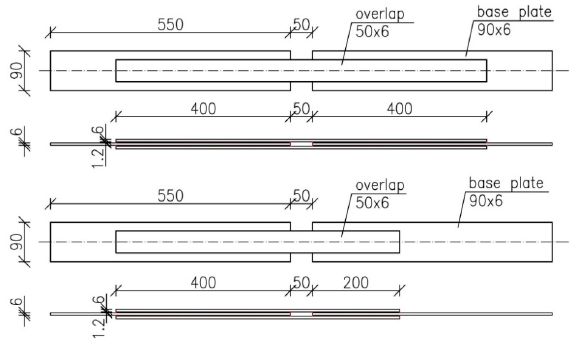
Figure 2. Detailed dimensions of the elements with an anchorage length of 400 mm and 200 mm.